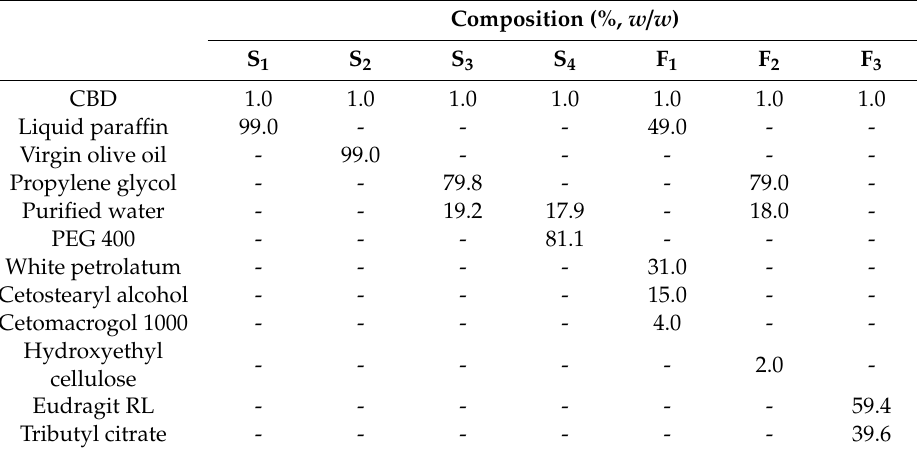
Table 2. Composition of solutions and vehicle